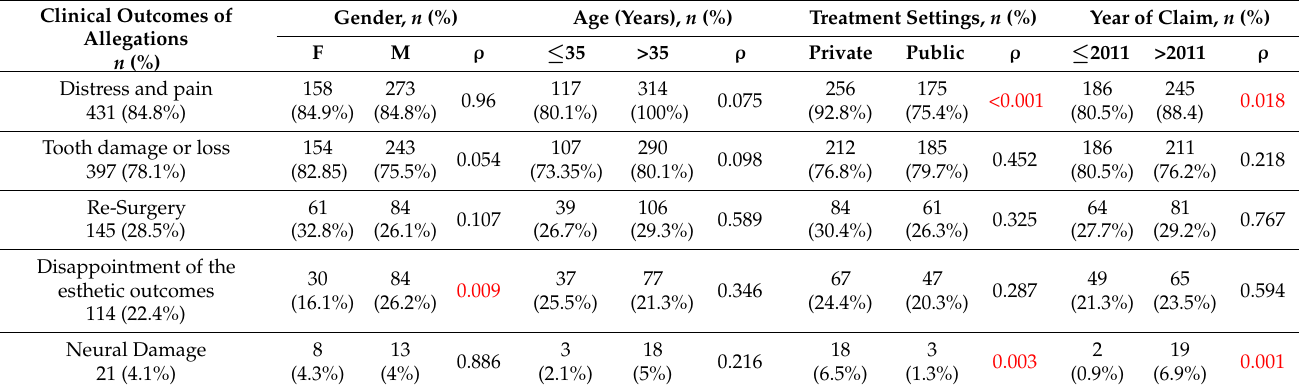
Table 3. Clinical outcomes of neglect of periodontal disease treatment divided by gender, age, treatment setting, and years. Clinical Outcomes of